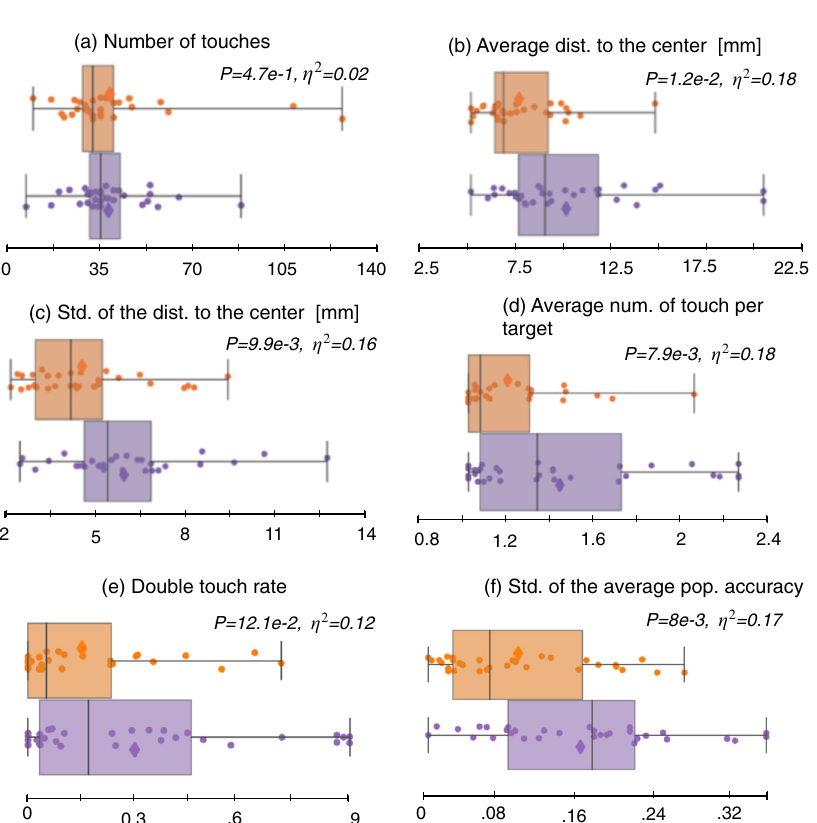
Fig. 3 Group comparisons of distributions of several touch-related features for autistic versus autistic + ADHD participants in study 2. These motor-related features show statistically signi fi cant differences between the groups (except for the number of touches ). The extracted features presented here are detailed in the features extraction section. P -values were computed using a one-way ANCOVA, and corrected using Benjamini – Hochberg procedure to control for FDR. Effect sizes are denoted as η 2 . The line within the boxplot represents the median, the box represents the interquartile range, and the whiskers show extreme values. Scatter points show feature values for each